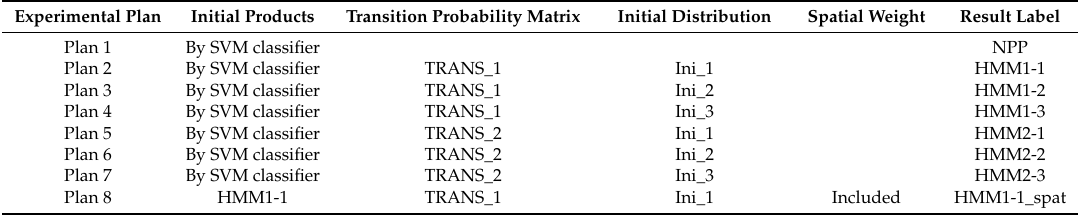
Table 3. Experimental